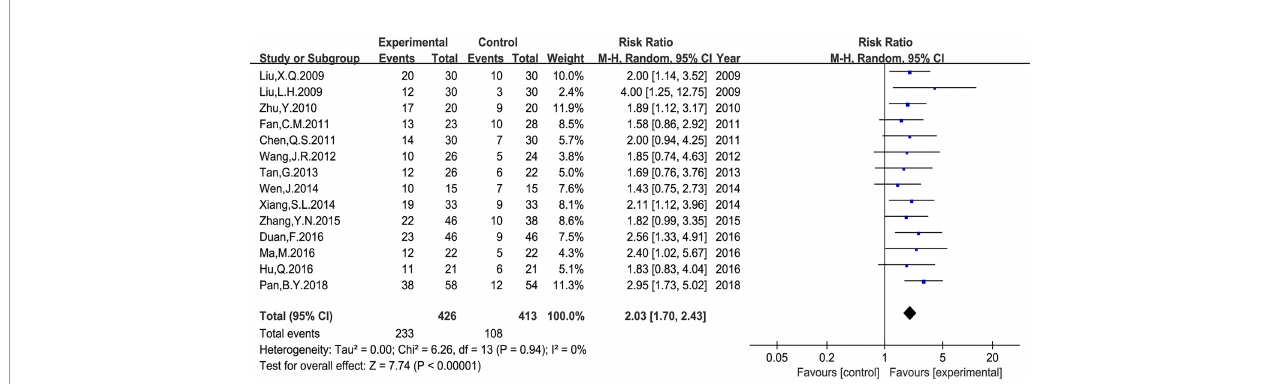
FIGURE 6 | Meta-analysis results of quality of life (QOL) according to the number of KPS